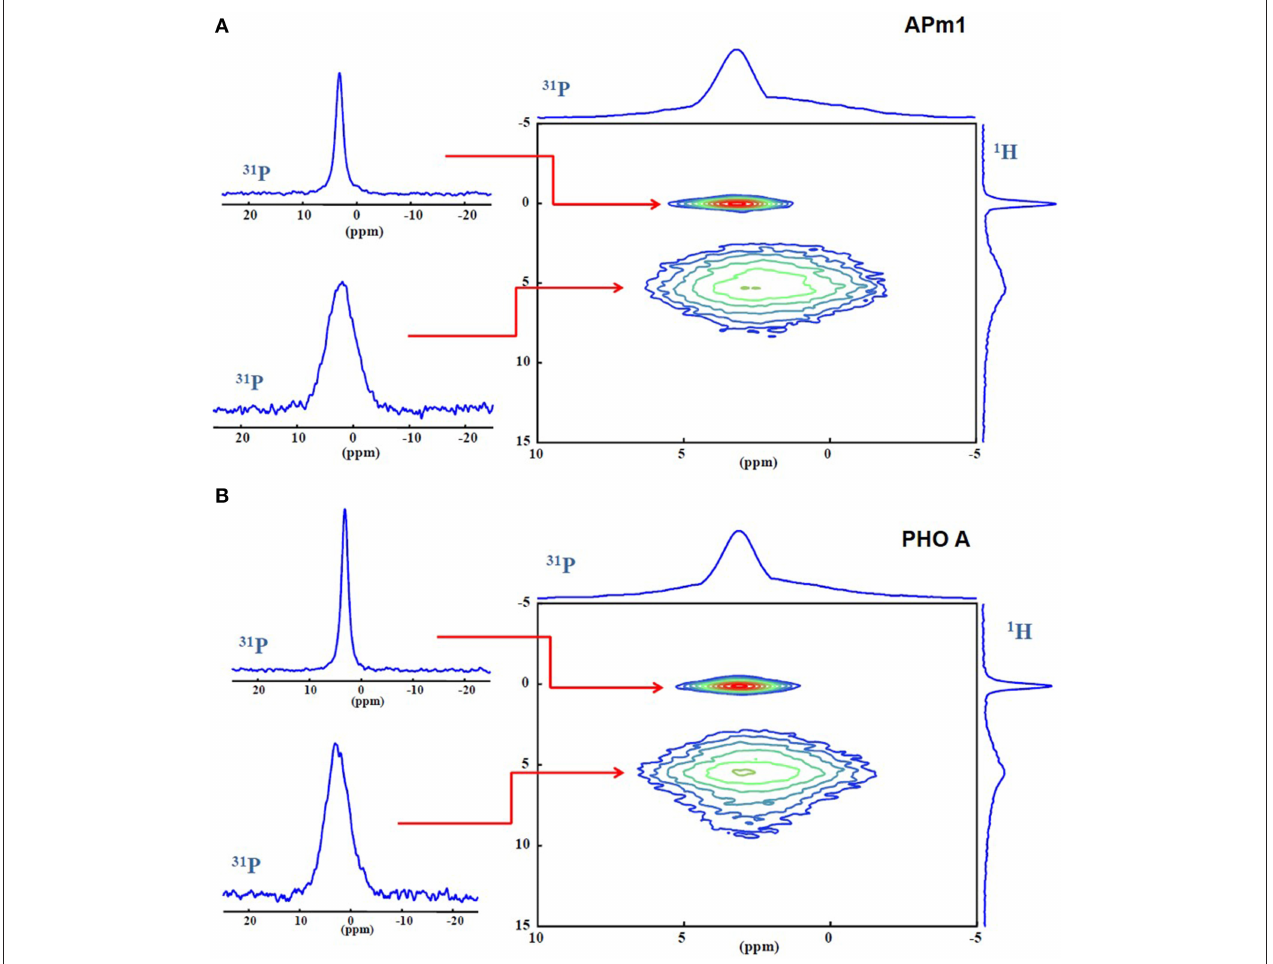
FIGURE 8 | (A) 1 H- 31 P HetCor spectra of the Ca-phosphate precipitates formed in the presence of APm1 (A) and PHO A (B), after 2 weeks in the calcification medium, and extracted 31 P slices at δ ( 1 H) = 0 and